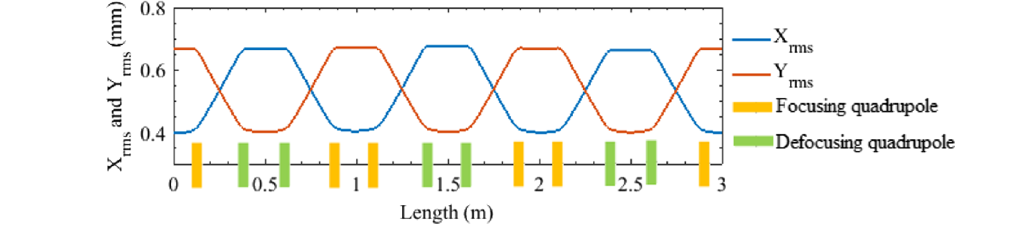
FIG. 5. Typical FFDD structure.